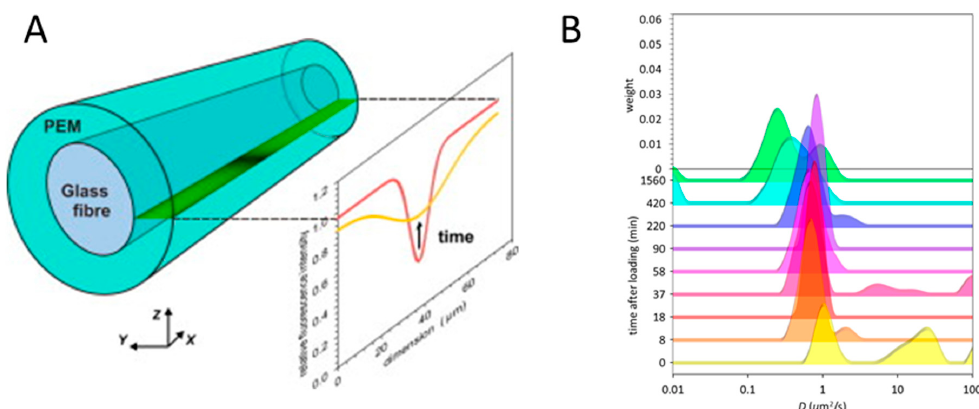
Figure 4. ( A ) Scheme of the microfibre coated with the PEM and the focal plane and FRAP experiment. Figure taken from reference [108], Copyright © 2020 Elsevier Ltd. ( B ) Distribution of diffusion coefficients of CytC loaded into (HA/PLL) 24 multilayers, where 24 is the number of polymer bilayers. Figure taken from reference [109], Copyright © 2020 American Chemical Society (https://pubs.acs.org/doi/10.1021/acs.jpcb.7b11051).